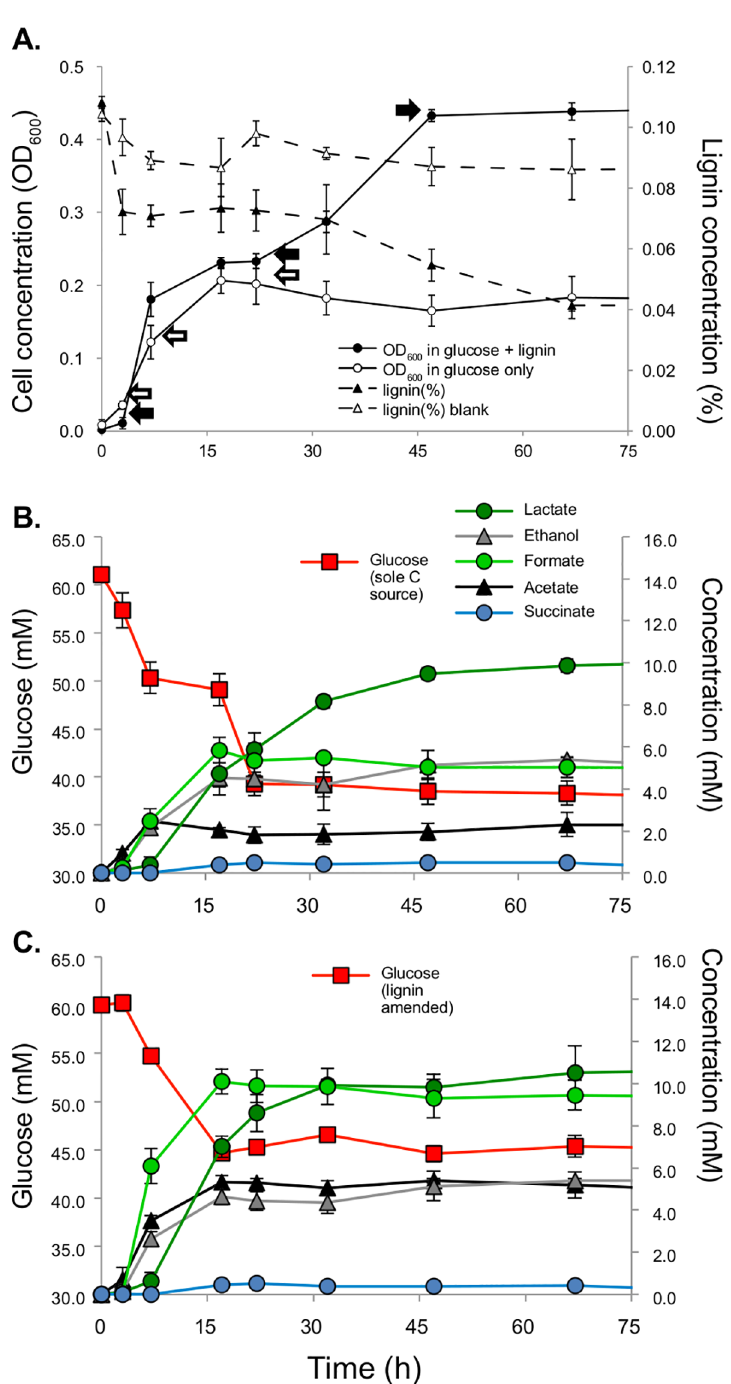
Fig 1. (A) Growth curve of Enterobacter lignolyticus SCF-1 in glucose medium (open circles) and glucose medium amendedwith lignin(closed circles). Arrows show the times samples were harvestedfor transcriptomic analysis(open arrows, glucose medium and closed arrows, glucosemedium amendedwith lignin).The concentration of lignin of amendedcultures is shown in closed trianglesand control (mediummas lignin, no cells) is shown in open triangles. Metabolites concentrations along growth of unamended cultures (B) and lignin amendedcultures (C) . Glucose is shown in red squares, ethanol, in gray triangles, acetate, in black triangles, lactate, in darker green circles, succinate in light blue and formate, lighter green circles.